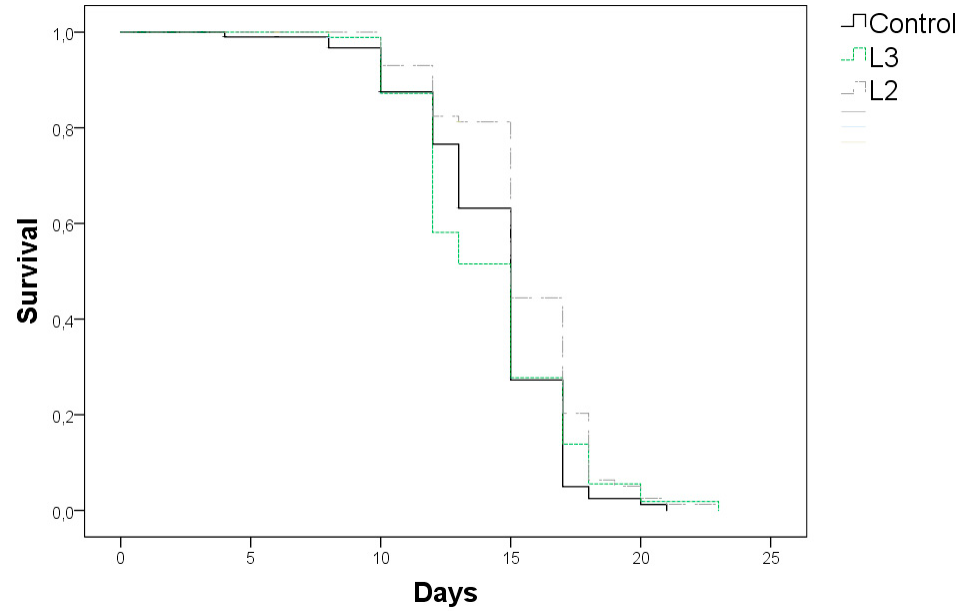
Figure 4. Survival curves of C. elegans wild-type N2 strain grown in culture media supplemented with L3 (100 µg/mL) or L2 extracts (250 µg/mL), compared to a control of untreated worms. Table 4. Influence of L3 extract 100 µg/mL and L2 extract 250 µg/mL in the culture medium on the lifespan of wild-type N2 C. elegans under normal grown conditions at 20 °C.